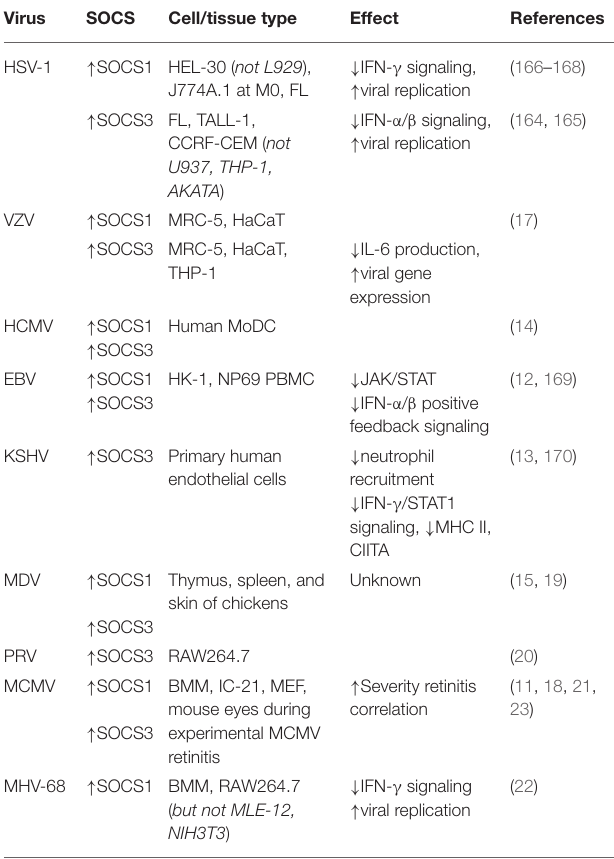
TABLE 2 | Herpesviruses that manipulate host SOCS